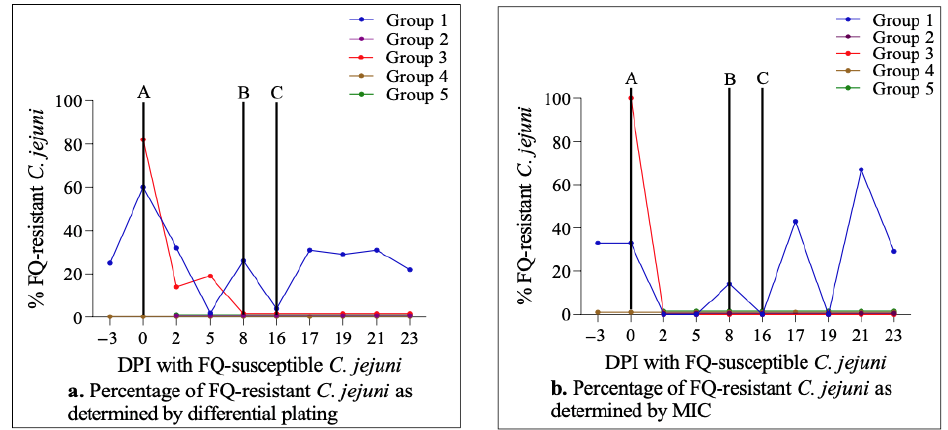
Figure 1. Dot plot analysis of Campylobacter colonization level (log 10 CFU/g feces) in cattle of groups 1–5. Panels ( a , c , e , g , i ) represent total C. jejuni CFUs (both susceptible and resistant), while ( b , d , f , h , j ) indicate FQ-resistant C. jejuni population. Each dot indicates the CFU number from an individual calf. The horizontal red bars depict the mean colonization levels, while the vertical red lines show the 95% confidence interval. Letter A designates the time when all calves were orally inoculated with FQ-susceptible C. jejuni , letter B denotes the time when M. haemolytica was given to the calves in Groups 4 and 5, and letter C depicts the day on which groups 2, 3, 4, and 5 received subcutaneous injection of enrofloxacin. The culture’s detection limit was approximately 100 CFU/g of feces (shown as dotted black lines over x-axis). DPI stands for day after inoculation.